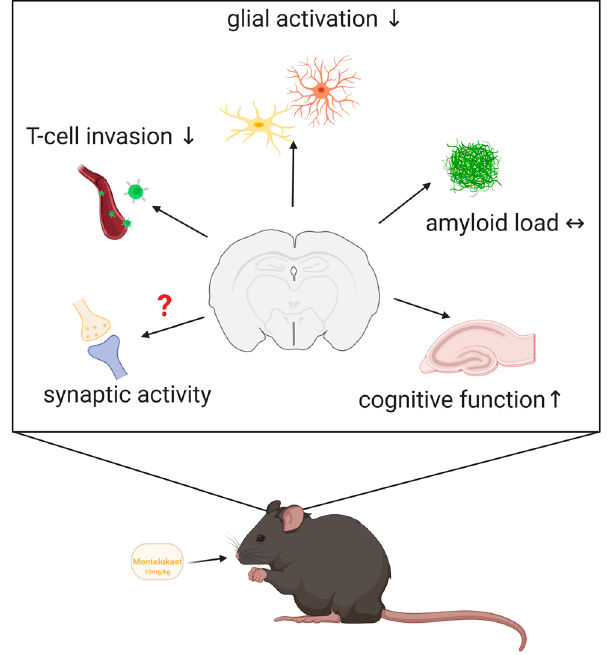
Figure 8. MTK has pleiotropic effects on the diseased brain. MTK treatment with 10 mg/kg/d has pleiotropic effects in the brain, i.e., reduced microglia activation and CD8+ T-cell invasion and improvement in cognition. Furthermore, MTK affects gene expression of genes related to synaptic activity.